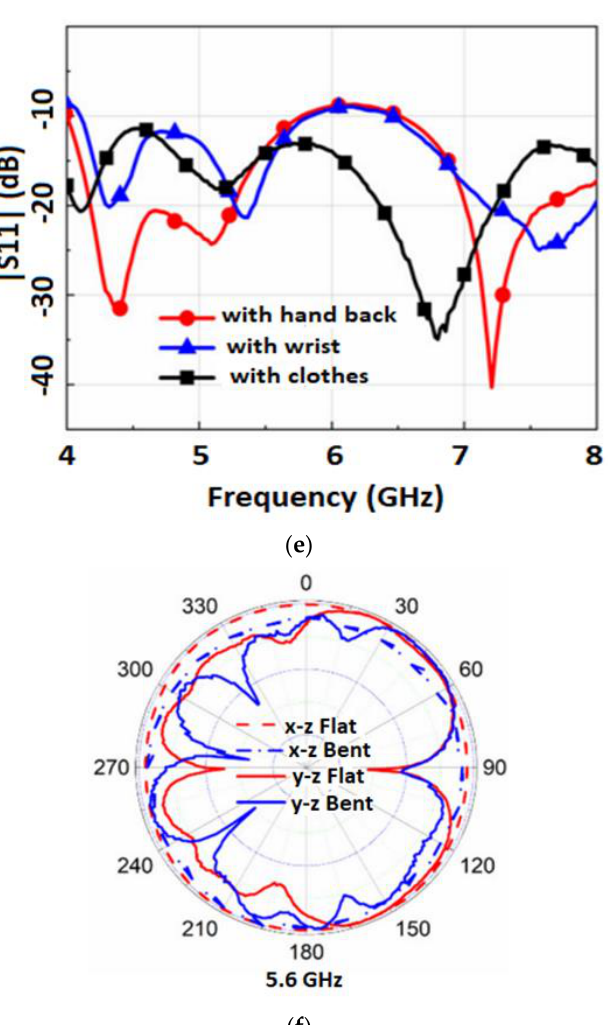
Figure 7 . ( a ) The GAF antenna prototype. ( b ) |S11| of the antenna. ( c ) |S11| of the antenna under bending. ( d ) Antennas under different bending scenarios. ( e ) |S11| curves when attached to the body. ( f ) Radiation pattern. Reprinted ( a – e ) from Ref. [59].